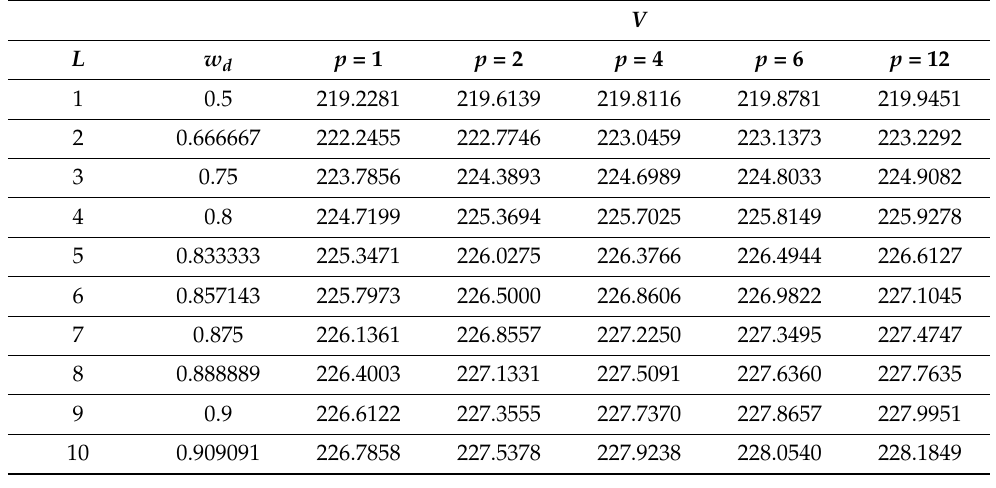
Table 3. Dependence of the company value, V , on leverage level L at different frequency of payments of tax on profit p for three-year company.